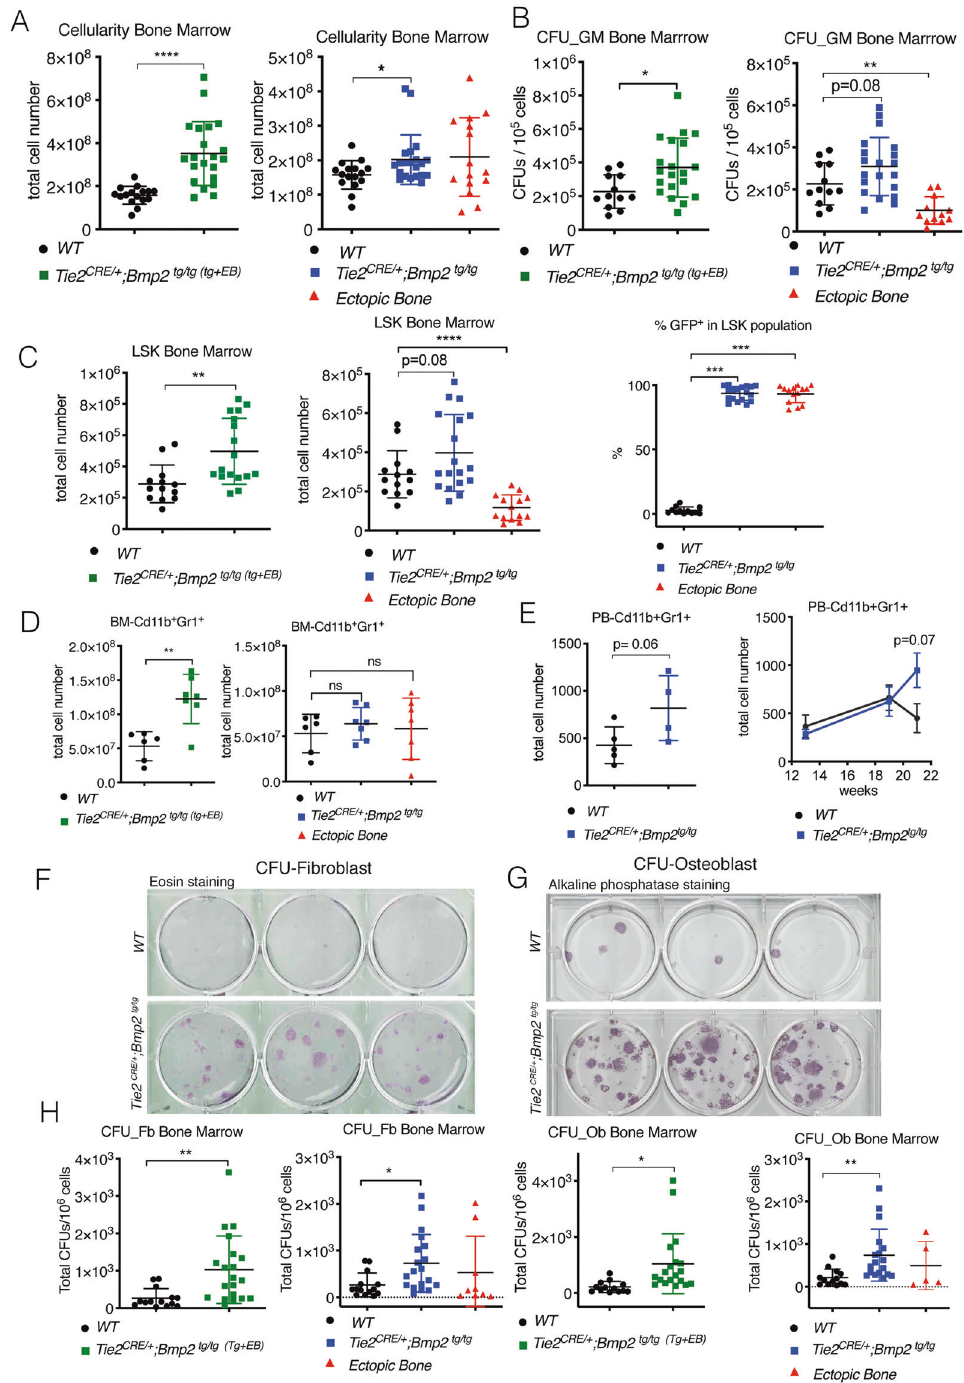
The chondrogenic marker Sox9 was expressed in ectopic bone chondrocyte nuclei (Supplementary Fig. 5C, left panel). Scattered Sox9 + nuclei were also found in GFP-expressing fi broblasts (Supplementary Fig. 5C, d ’ ) and damaged skeletal muscle fi ber cytoplasm identi fi ed by central nuclei (Fig. 5B, c ’ and d ’ , and Supplementary Fig. 5C, c ’ ). This expression pattern was also observed in areas next to HO, although involving very few nuclei (Supplementary Fig. 5C, c ’ , open arrowheads). The osteogenic marker Osterix, was also detected amongst Sox9- expressing cells in consecutive sections (Fig. 5C, e ’ , and f ’ ) and in ectopic bone osteoblasts (Supplementary Fig. 5D,